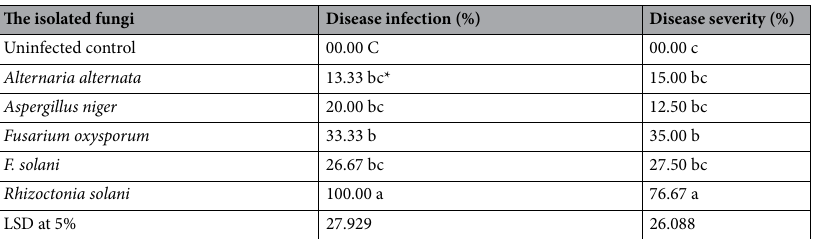
Table 5. Pathogenicity of fungal species on lucky bamboo plants in vase under laboratory conditions, after 4 weeks survey. *Values are means of five replicates; each replicate contains three bamboos (plant/vase). values within the same column followed by a different letter(s) are significantly different at 0.05 of probability.